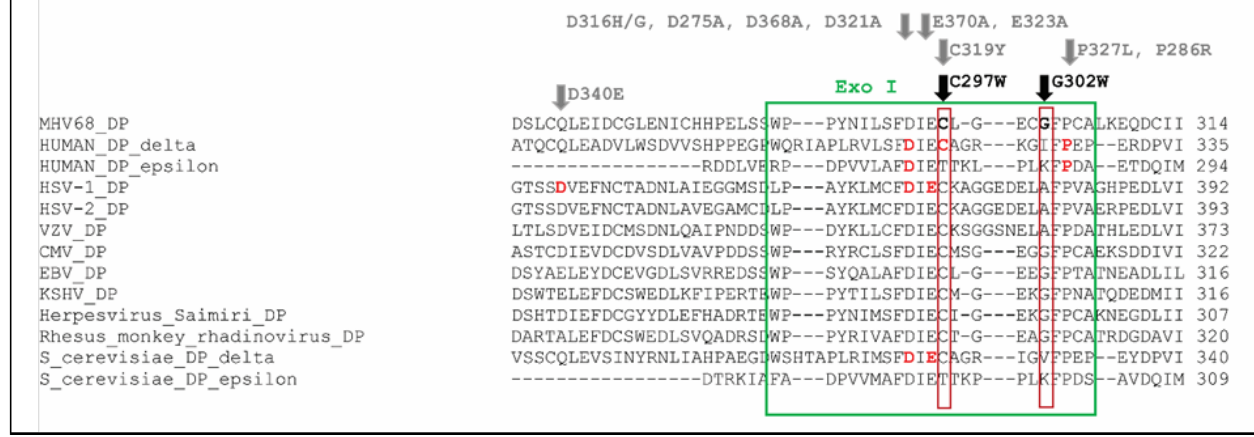
Figure 6. Alignment of MHV-68 DP with human DNA polymerase delta, human DNA polymerase epsilon, HSV-1 DP, HSV-2 DP, VZV DP, HCMV DP, EBV DP, KSHV DP, herpesvirus saimiri DP, rhesus rhadinovirus DP, S. Cerevisiae DNA polymerase delta and S. Cerevisiae DNA polymerase epsilon. The cysteine at position 297 (marked in bold) is in the Exo I domain (green box) of MHV-68 DP, and it is extremely conserved among B family DNA polymerases. It is part of the FDIEC amino acid sequence, in which amino acid changes are frequently associated with the formation of a mutator phenotype. The amino acid positions associated with a mutator are marked in bold red and encompass the following amino acid changes: human DNA polymerase delta: D316H, D316G, C319Y, P327L; human DNA polymerase epsilon: D275A, P286R; HSV-1 DP: D368A, E370A; S. Cerevisiae DNA polymerase delta: D321A, E323A (stated in gray) [51–65] .